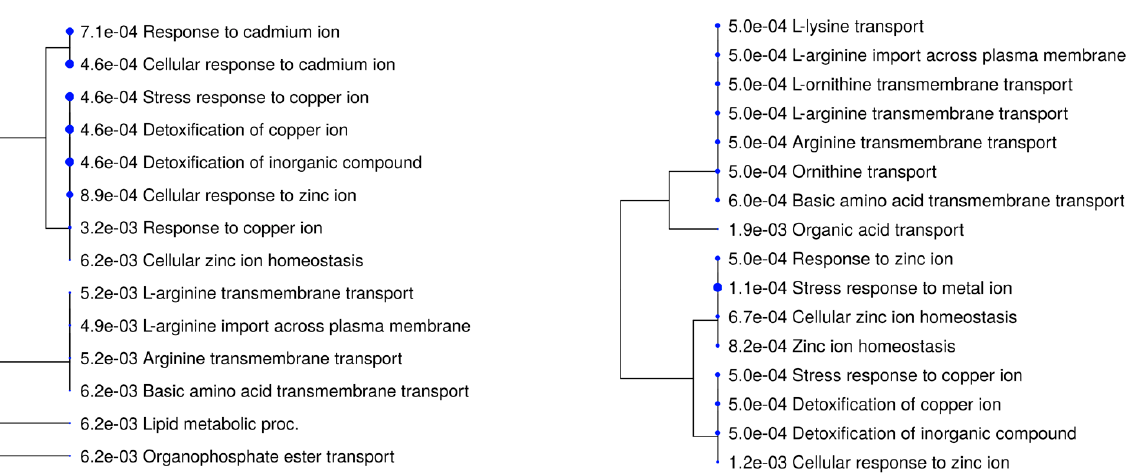
Figure 3. Functional over-representation analysis of differentially expressed genes in fetal liver tissues. Biological processes over-represented are based on the DEGs of VTM_MG vs. NoVTM_MG ( a ) and VTM_LG vs. NoVTM_LG ( b ) comparisons. The terms are hierarchically arranged based on functional similarity. The bigger the blue dot, the more significant the term is (FDR ≤ 0.05). The k -means clustering analysis, followed by functional over-representation, provided insights into the molecular pathways underlying gene expressions and their involvement with liver function. Based on the k- means approach, we clustered 2000 genes in four clusters (Table 1). Cluster A grouped 702 genes involved with pathways such as retinol metabolism, arachidonic acid metabolism, and the PPAR signaling pathway (FDR < 0.05). Additional pathways related to metabolism included PI3K-Akt signaling and oxi- dative phosphorylation, which were identified in clusters B ( n = 577) and D ( n = 364), re- spectively. The genes within each cluster and the k- means values are reported in Table S11. The over-represented pathways and genes for all clusters are reported in Table S12 (FDR < 0.05). Table 1. k- means clusters and key over-represented pathways involved with fetal liver function. Cluster